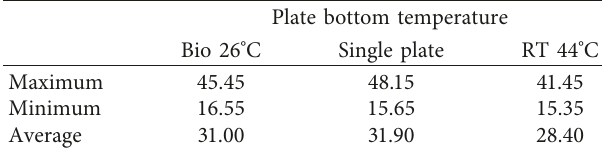
Table 6: Plate bottom temperature measurements of Test 1 ( °